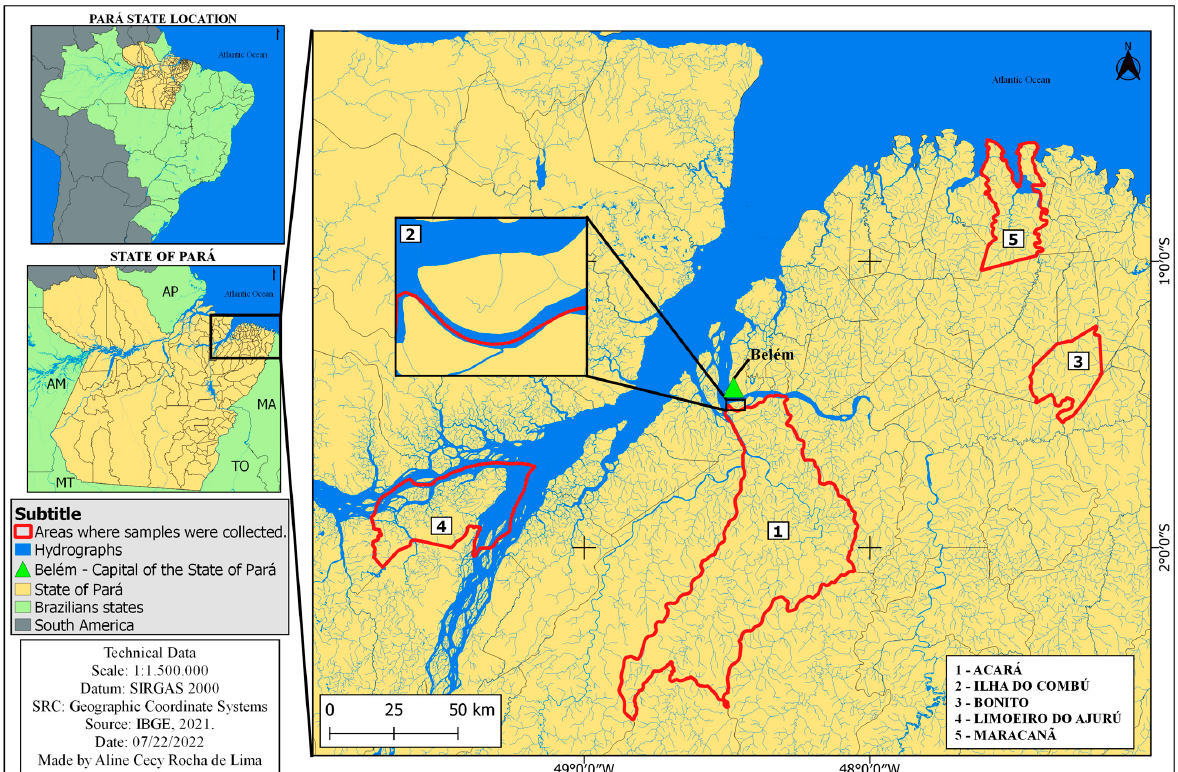
Figure 1. Geographic locations of collection areas for riverine and rural populations in the state of Pará.